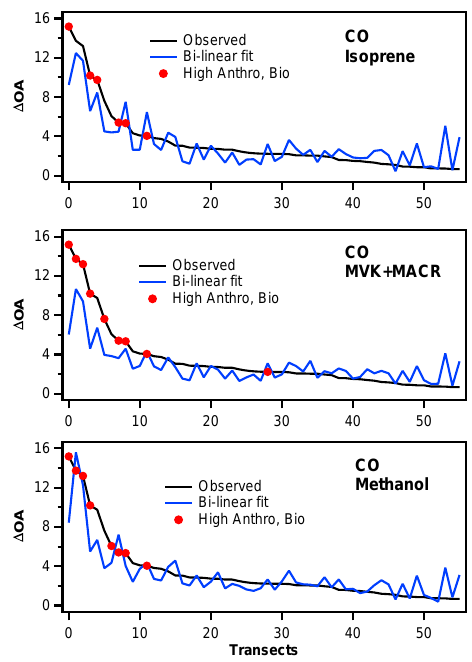
Figure 11. Observed (cid:49) OA presented in descending order. Blue trace is (cid:49) OA from bilinear model using (cid:49) CO and (a) Isoprene, (b) (cid:49) MVK + MACR, and (c) (cid:49) CH 3 OH as explanatory variables. Regressions did not use transects from the high (cid:49) CO, high (cid:49) Bio subsets, indicated by red